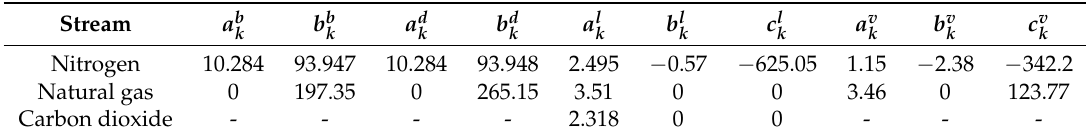
Table 3. Specification for stream properties.